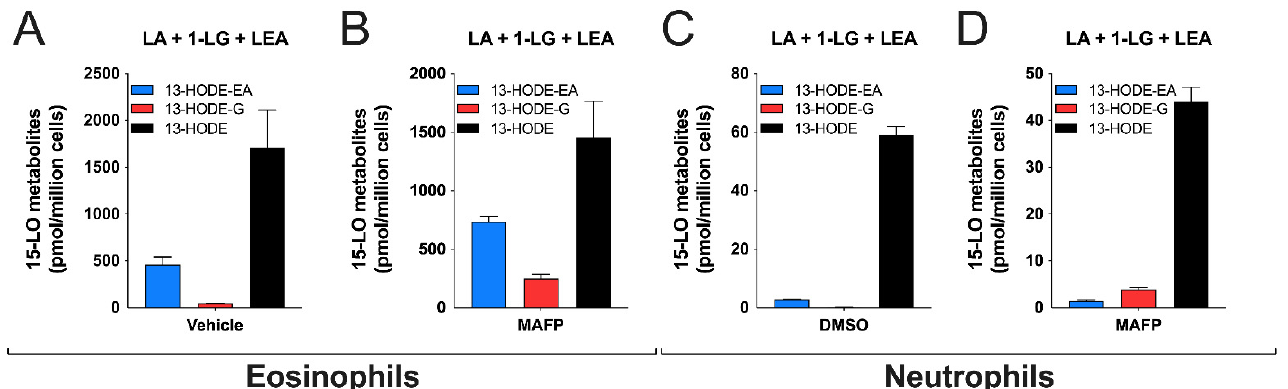
Figure 8. Substrate preference by human eosinophils and neutrophils. Pre-warmed (37 °C) human eosinophil suspensions (10 6 cells/mL in HBSS containing 1.6 mM CaCl 2 ) or neutrophil suspensions (5 × 10 6 cells/mL in HBSS containing 1.6 mM CaCl 2 ) were pre-treated with DMSO ( A , C ) or MAFP ( B , D ) for 5 min before the addition of a mixture of 1-LG, LEA, and LA at 3 µM each. Incubations were stopped after 5 min by the addition of one volume of cold ( − 20 °C) MeOH containing the internal standards. Samples then were processed for LC-MS/MS analyses as described in methods. Results are the mean (±SEM) of 4 independent experiments.